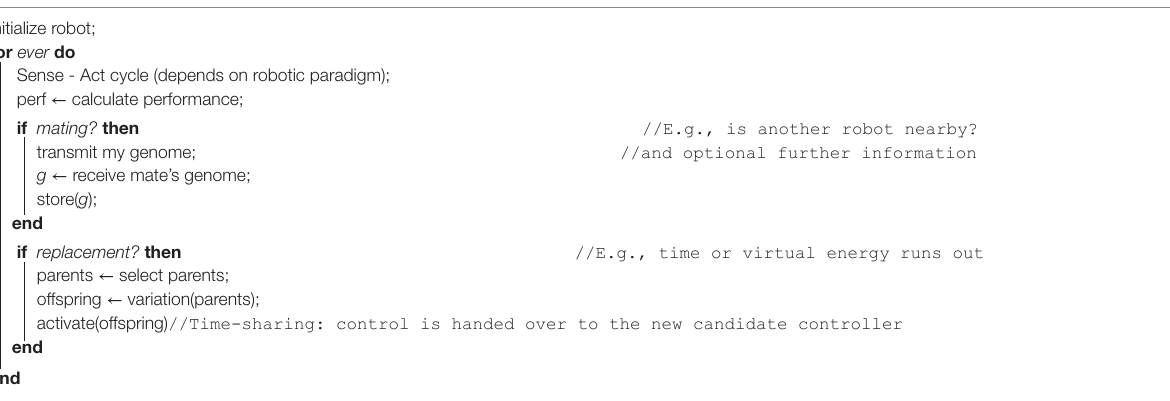
ALGORiTHM 1 | An individual robot’s control loop for embodied